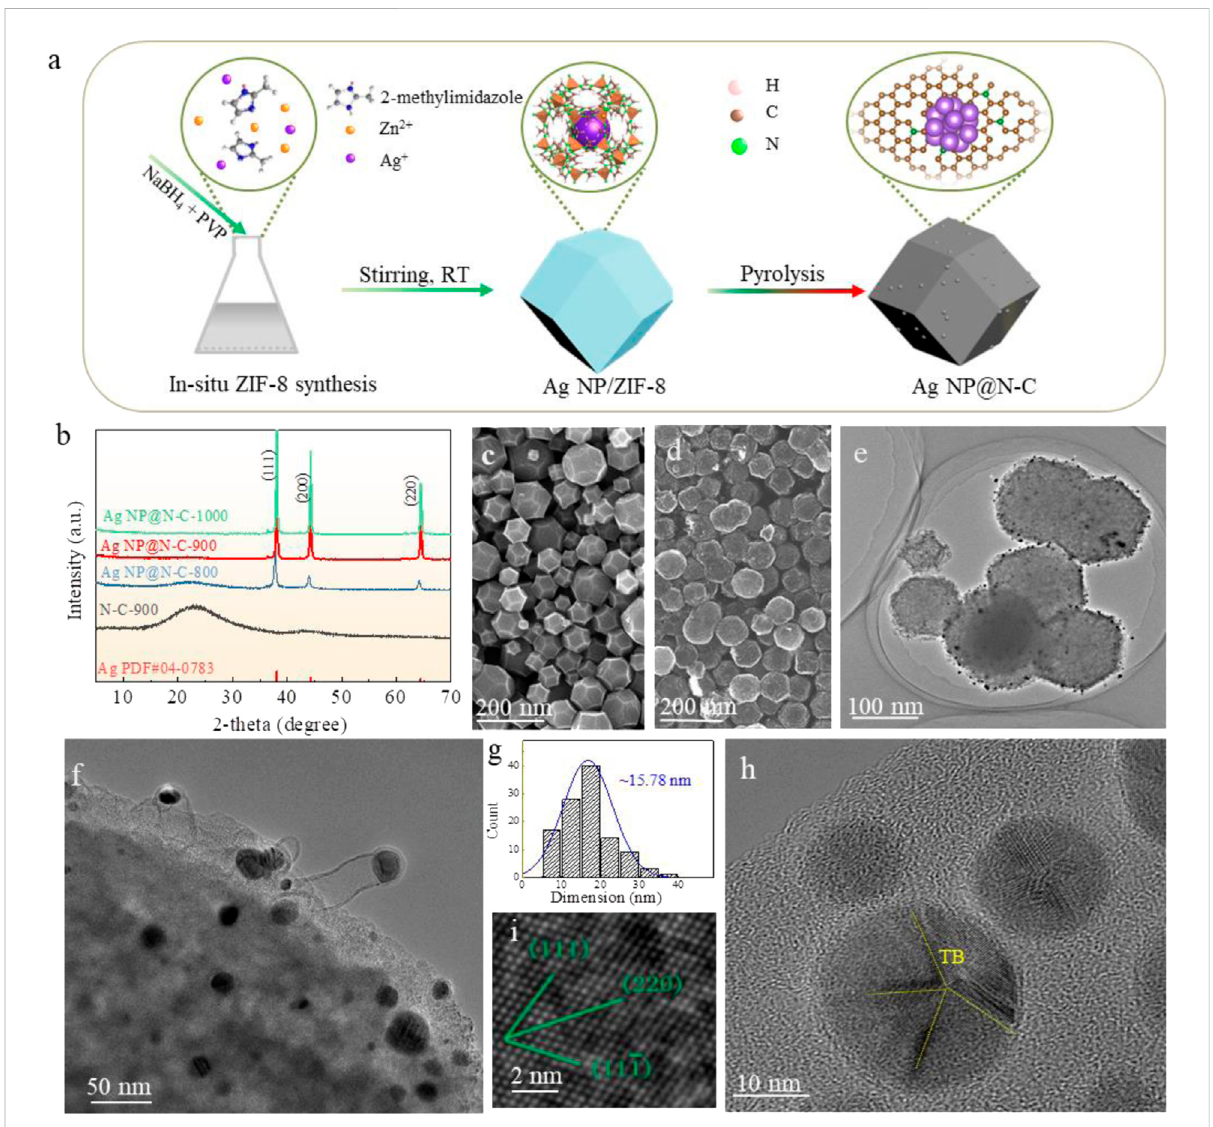
FIGURE 1 Microstructurecharacterizatics. (A) SchematicofthesynthesisprocedureofAgNP@N-C, (B) XRDpatternsofrepresentativeN-C-900,AgNP@ N-C-800,Ag NP@N-C-900and AgNP@N-C-1000. (C , D) Typical SEM imageoftheZIF-8 (C) and AgNP@N-C-900 (D) . (E – H) Typical TEMimageof theAgNP@N-C-900sample.TEMimageoftheAgNP@N-C-900sample (E , F) .High-magni fi cationTEMimage (I) , (G) theparticlesizedistributionof Ag, (H) nano twin boundaries in silver